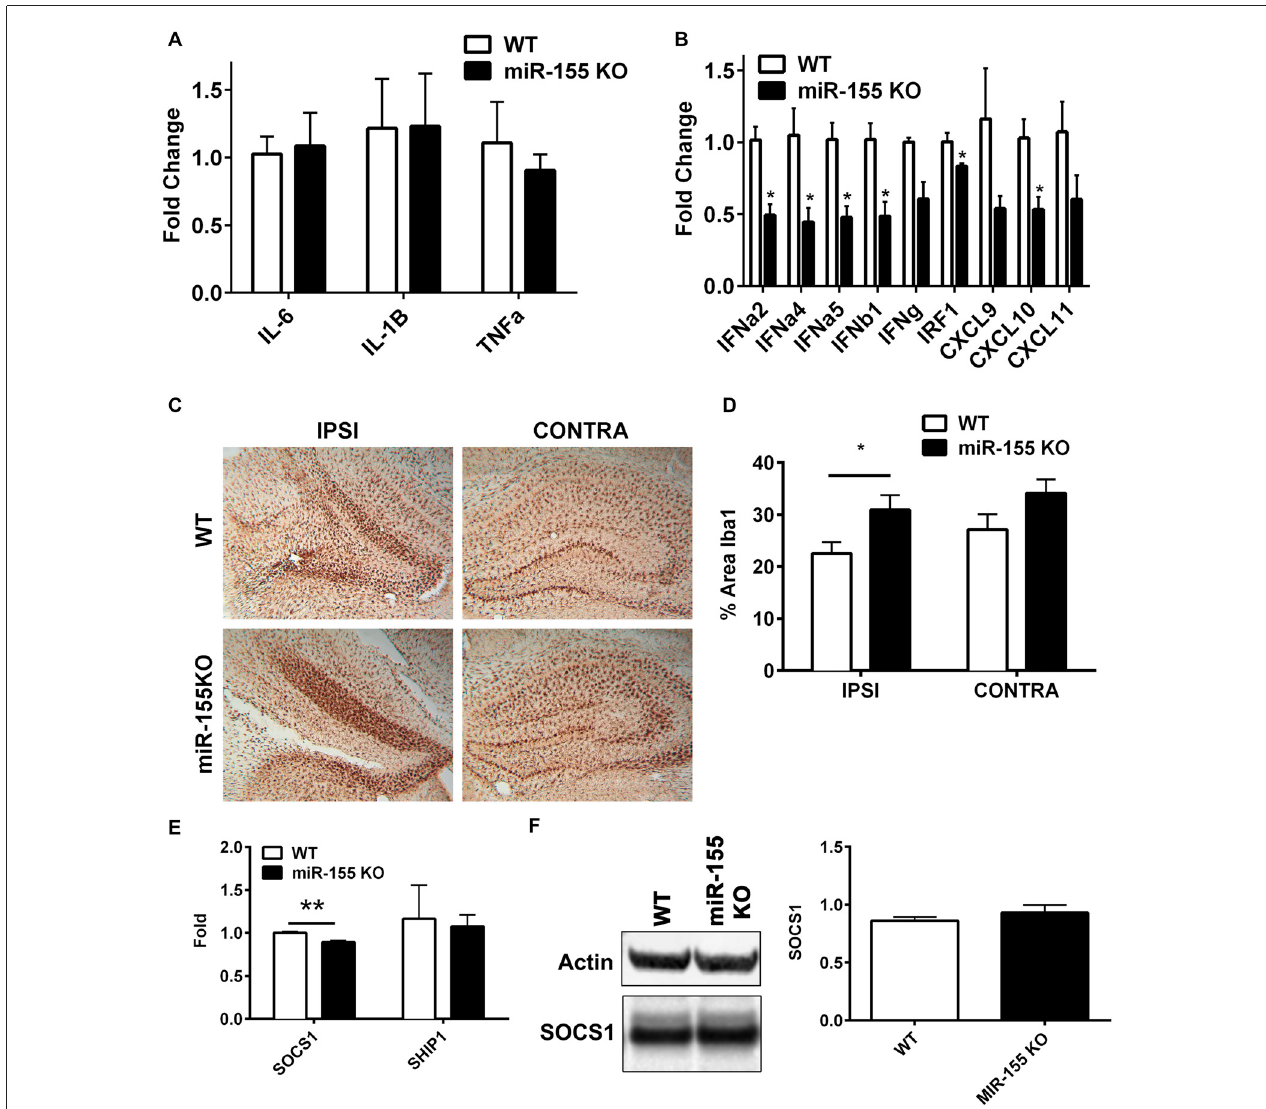
FIGURE 3 | miR-155 KO mice have a dampened hippocampal interferon (IFN) response to CCI. (A) Levels of pro-inflammatory cytokines IL-6 , TNF α and IL1 β , and (B) IFNs, IFN regulatory factor 1 ( IRF1 ) and IFN-induced chemokines in the ipsilateral hippocampus were measured 3 days after severe CCI by qPCR in miR-155 KO and WT mice. Data are expressed as fold change relative to WT, the mean ± SEM are shown ( n = 4). ∗ FDR < 0.05. (C) Brains from WT and miR-155 KO mice were stained for Iba1 3 days after severe CCI. Representative images are shown. (D) Quantification of Iba1 staining of WT ( n = 5) and miR-155 KO ( n = 6) ipsilateral hippocampi. The mean ± SEM are shown. ∗ P = 0.046 by Student’s T -test. (E) Levels of suppressor of SOCS1 and SHIP1 mRNA and (F) SOCS1 protein in the ipsilateral and contralateral hippocampus were measured 3 days after severe CCI in WT ( n = 4) and KO ( n = 4) mice by qPCR and Western blot respectively. The mean ± SEM from are shown. ∗∗ P = 0.0072 by Student’s T